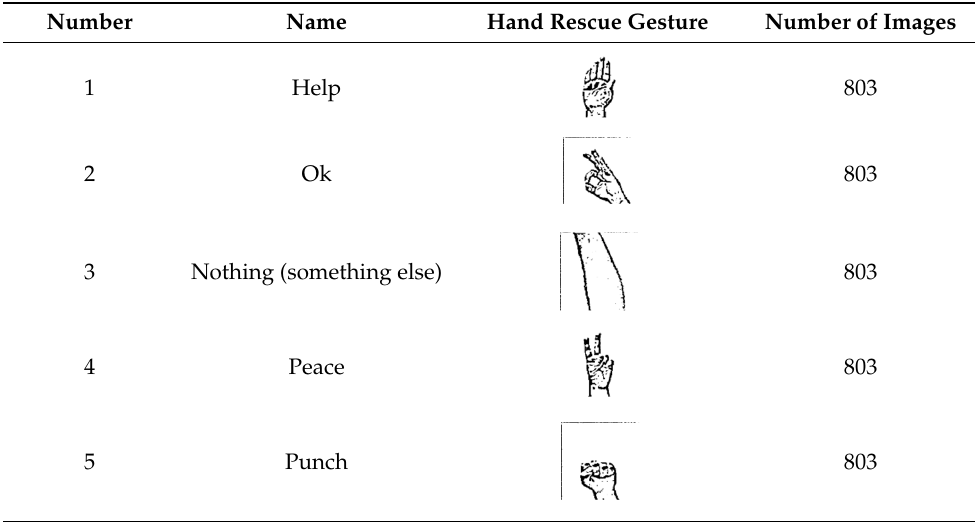
Table 5. UAV hand rescue gesture Table 5. UAV hand rescue gesture dataset. Table 5. UAV hand rescue gesture dataset. Table 5. UAV hand rescue gesture dataset. Table 5. UAV hand rescue gesture dataset. Table 5. UAV hand rescue gesture dataset.